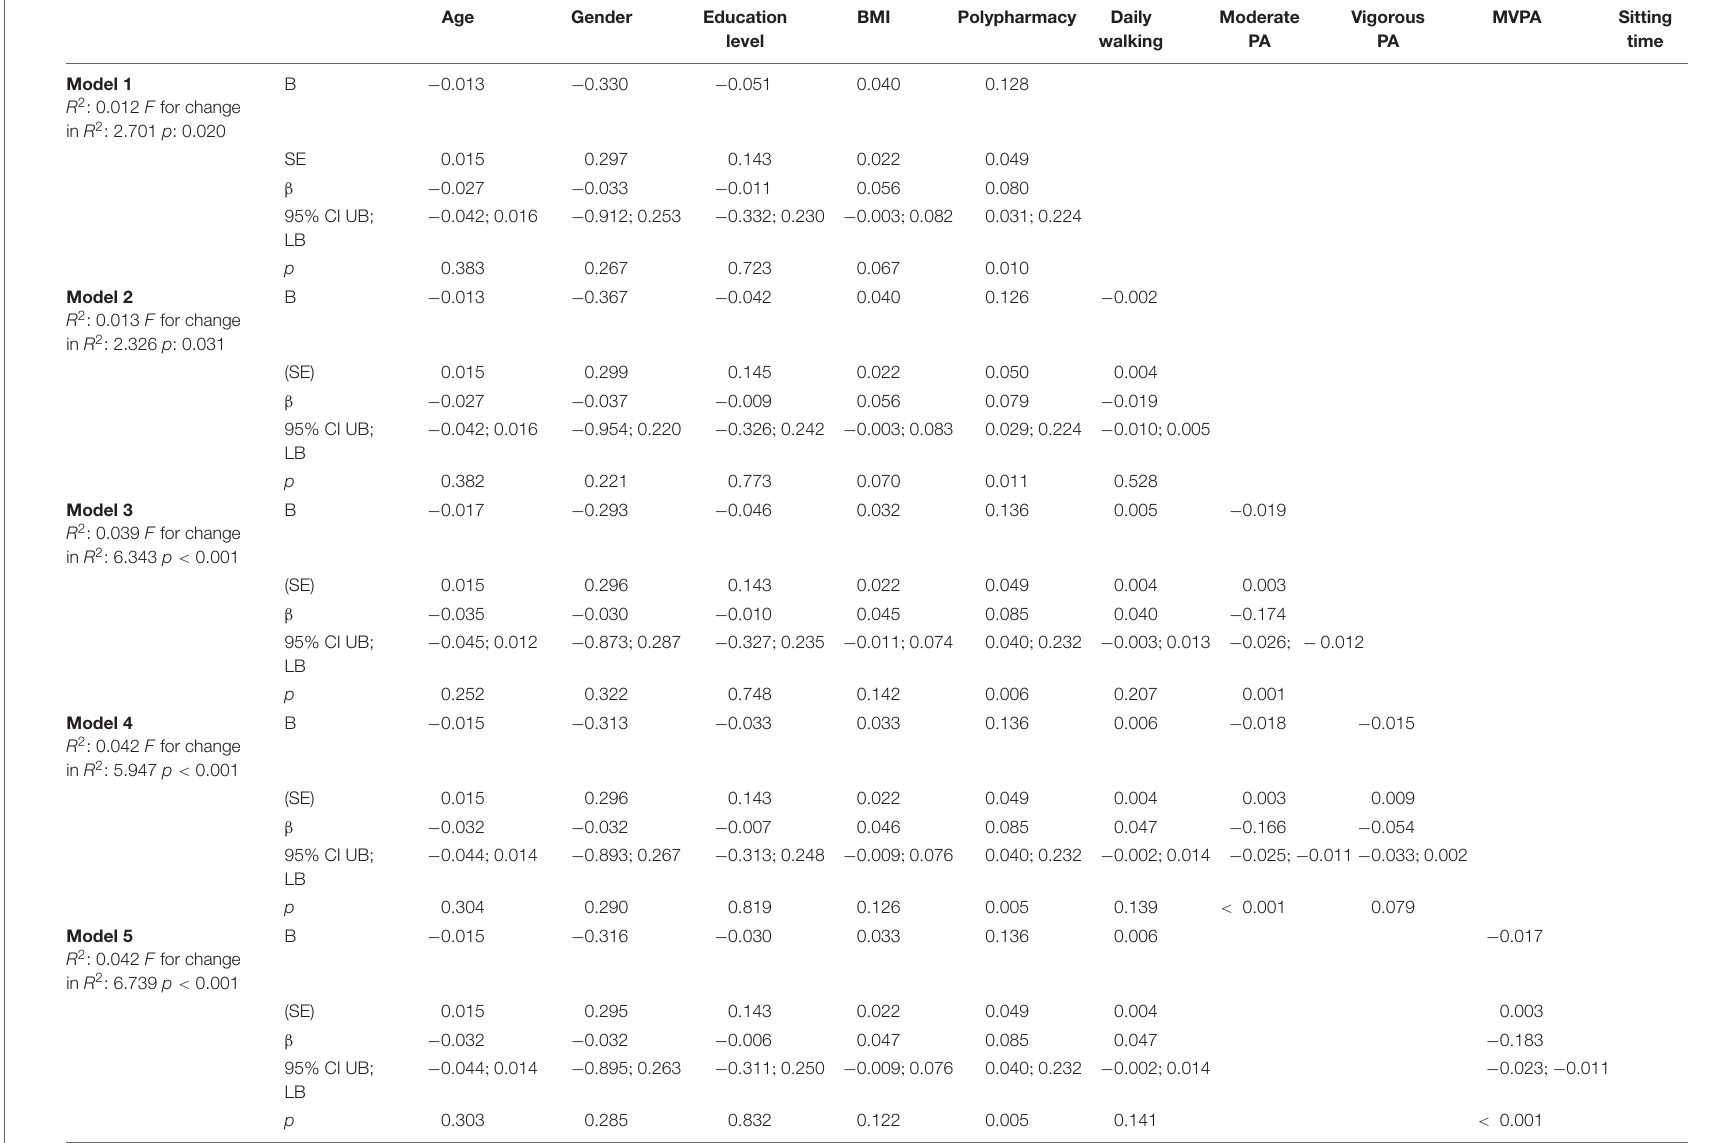
TABLE 2 | Hierarchical linear regression results for physical activity variables as a predictor of symptoms of depression.